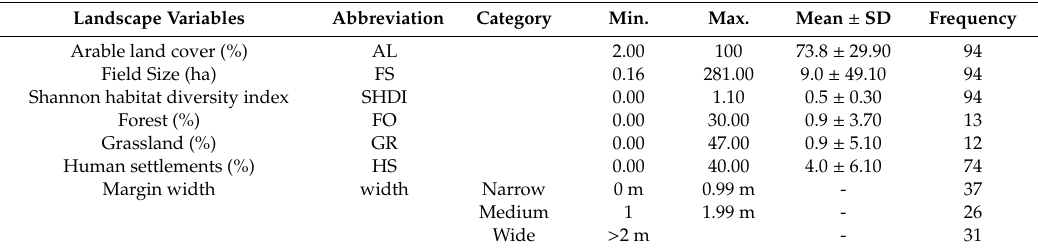
Table 5. Agricultural intensification variables of the 94 studied field